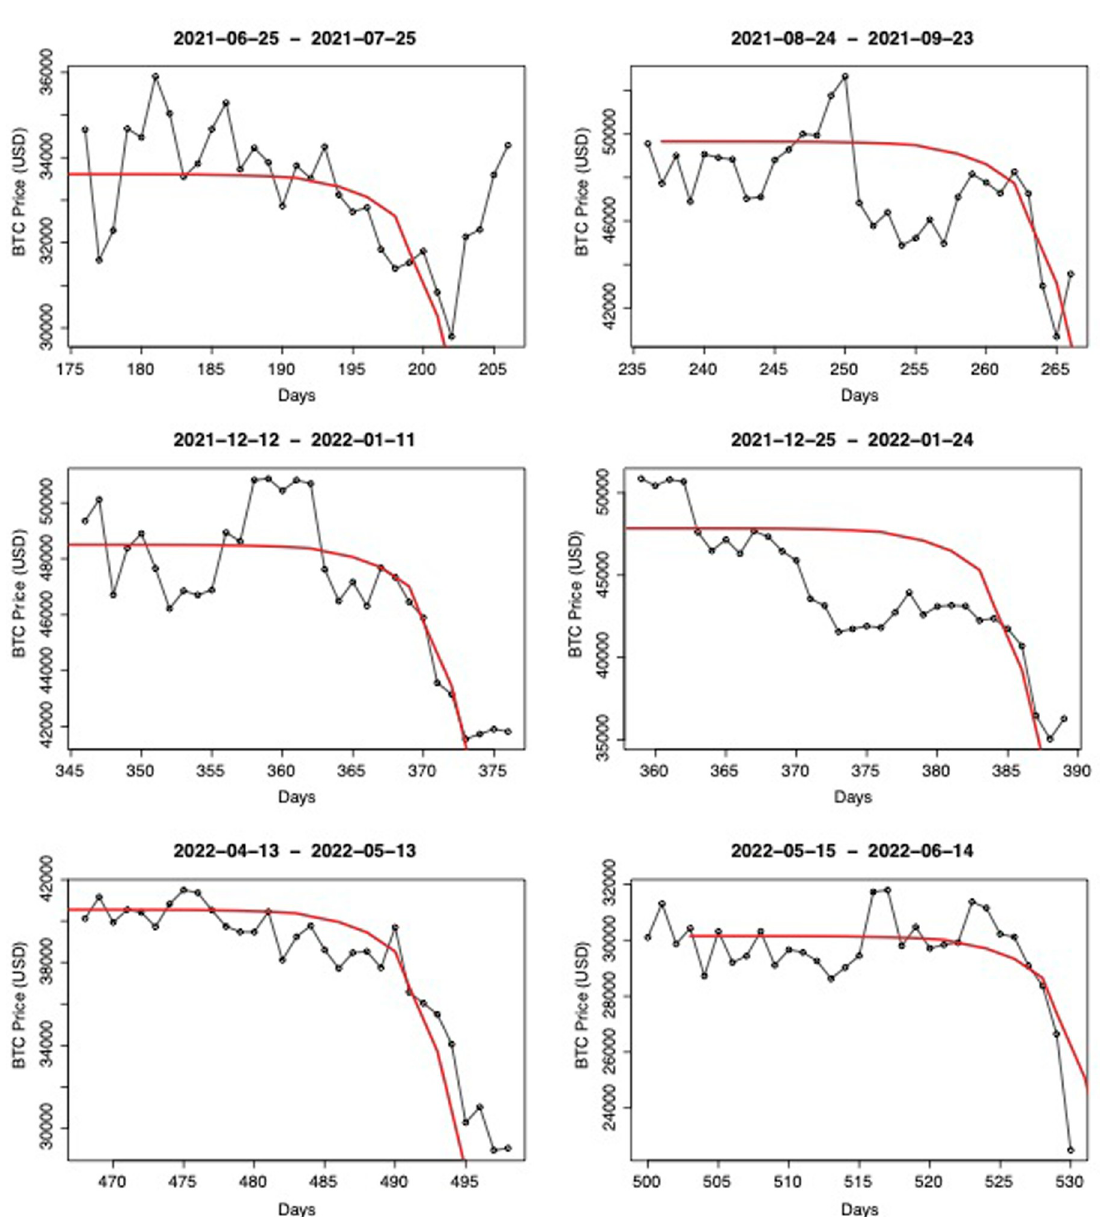
Fig 8. Preliminary search for price decreases for the period 01 Jan. 2021–14 Jun. 2022. We show that the hockey stick function could explain price decreases as well; although the time of development is shorter (days) and likely rooted in the intra-day trading activity.